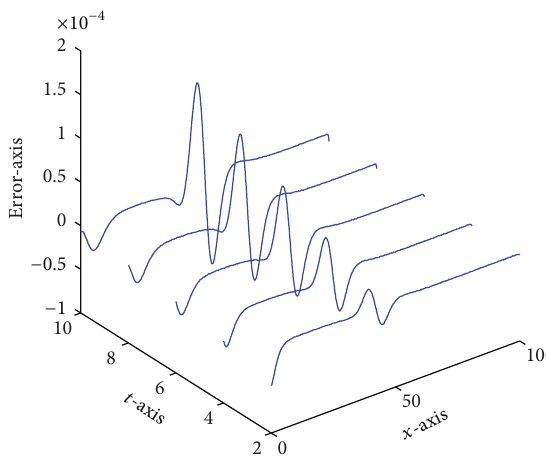
Figure2:Errorgraphfor 𝑐 = 0.05 , ℎ = 0.2 , 𝑘 = 0.2 and 𝑥 0 = 40, 0 ≤ 𝑥 ≤ 100 .